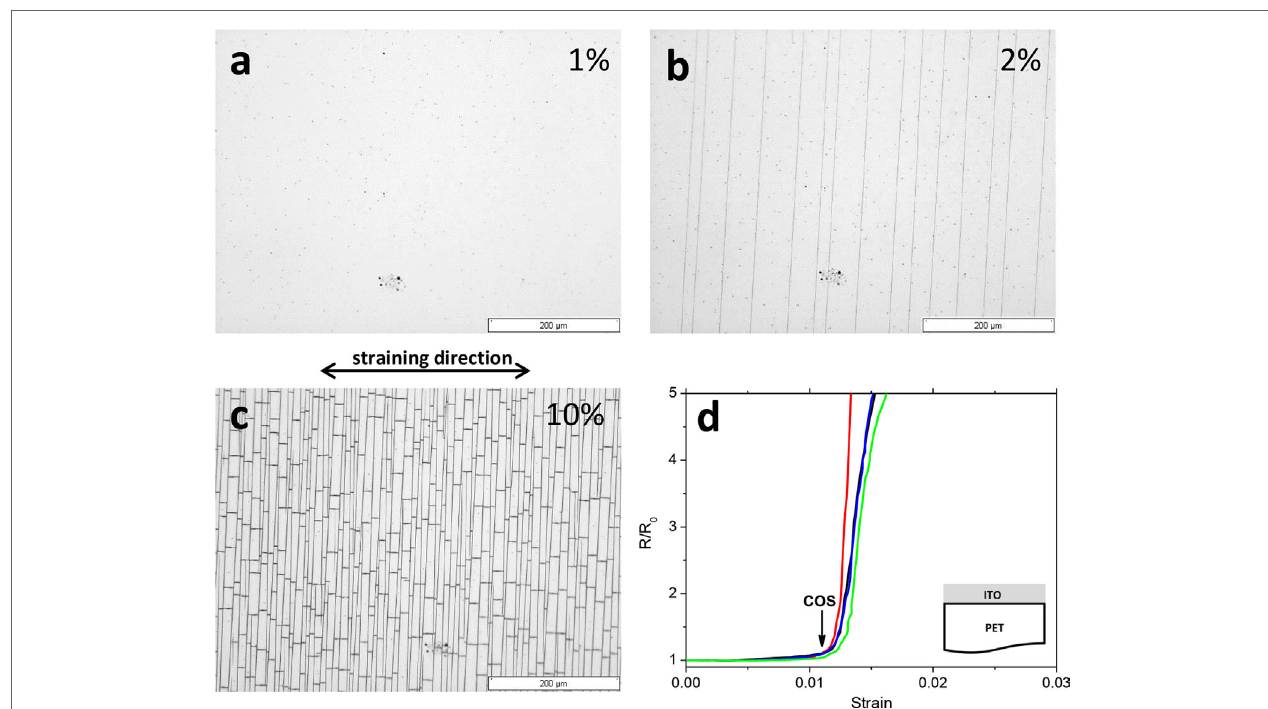
FigUre 1 | Tensile testing of a 100-nm thick iTO films on PeT . (a–c) Optical images of the same surface area taken in situ at different applied strain values. (D) Electrical resistance of three ITO samples measured in situ during